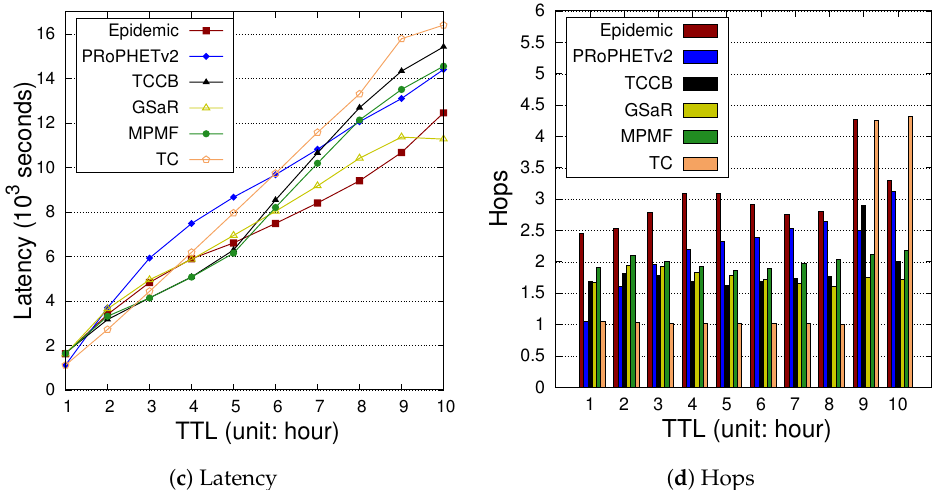
Figure 9. Performance comparison of MPMF in TVCM trace ( W 0 = 0.6, L = 10, (cid:101) = 50, α = 0.5, and buffer size = 10 MB).